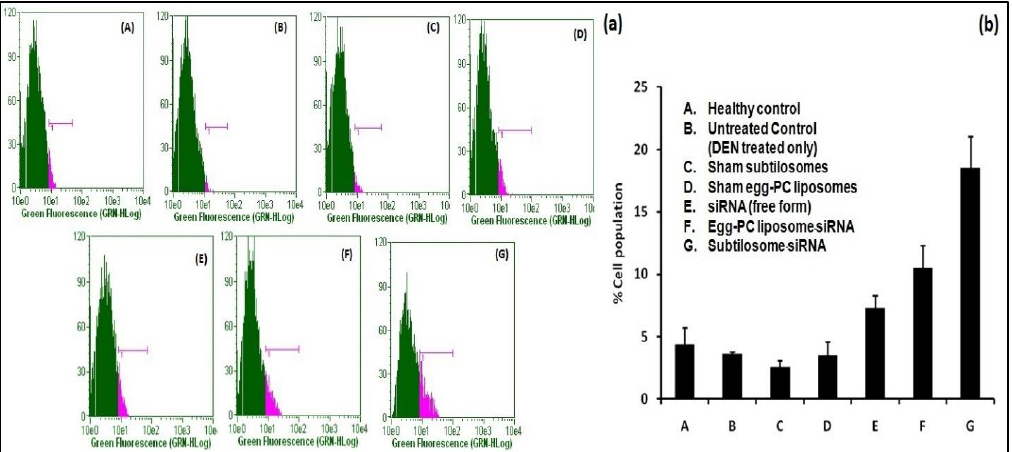
Figure 5. Apoptosis in liver cells analyzed by BrdU staining. Staining was performed using a BrdU staining kit (BD Biosciences), as described in the Materials and Methods section. ( a ) Stained-cell population from various groups of experimental animals treated with siRNA formulations where A, B, C, D, E, F and G represent healthy control, untreated control ( DEN treated only), sham sub- tilosome treated, sham egg-PC liposome treated, free siRNA treated, egg-PC liposome siRNA treated and subtilosome siRNA treated groups, respectively. ( b ) The total percentage cell popula- tion (depicted as bar diagram) observed in various experimental groups.